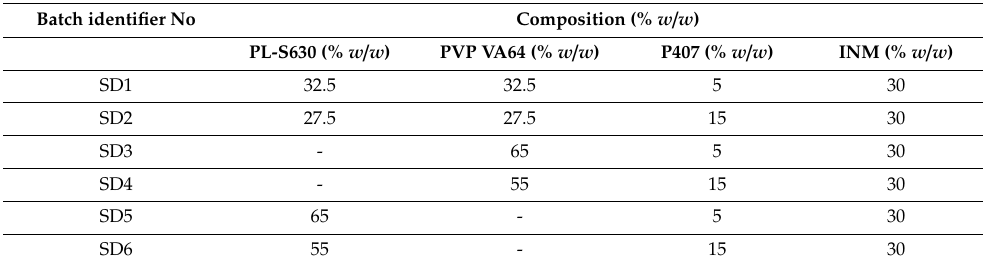
Table 1. Drug / carrier percentages of the HME processed